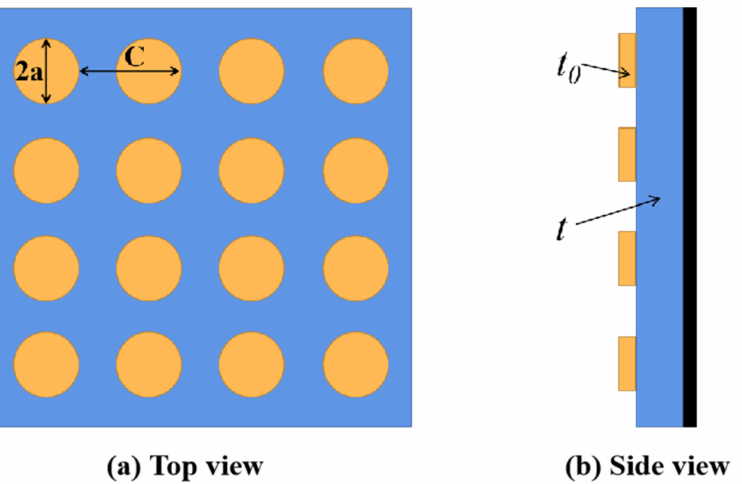
Figure 1. Structure diagram of RAM. The circular radius is a and the period length is C , the thickness of ceramic layer is t . ( a ) Top view, ( b ) side